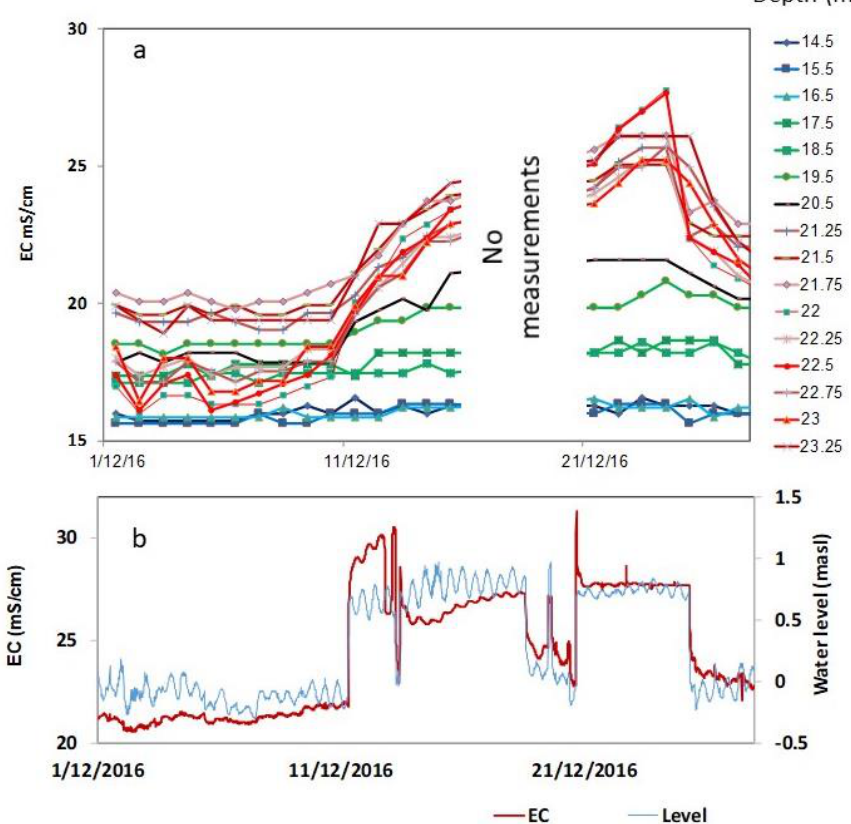
Figure 11. SMD ( a ) and CTD ( b ) measurements in well 71-2 during times of shutdown of the pump in well 211. The CTD was located at depth of 20.5 m with 0.5-h frequency while SMD was in 1-day frequency.